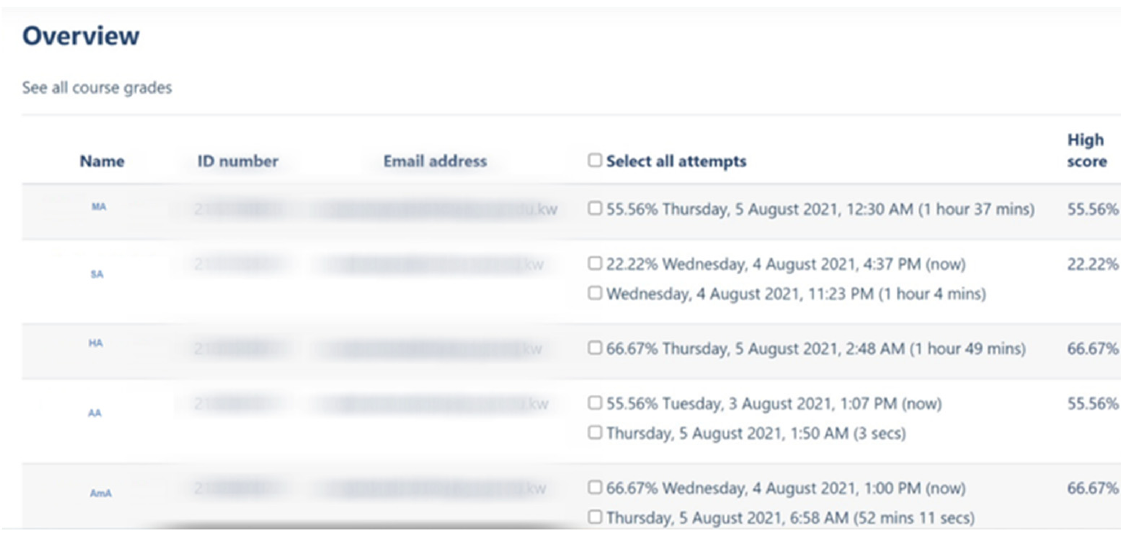
Figure 6. Screenshot of the attempt report of students. The student’s IDs and mail addresses are not disclosed to protect their privacy.